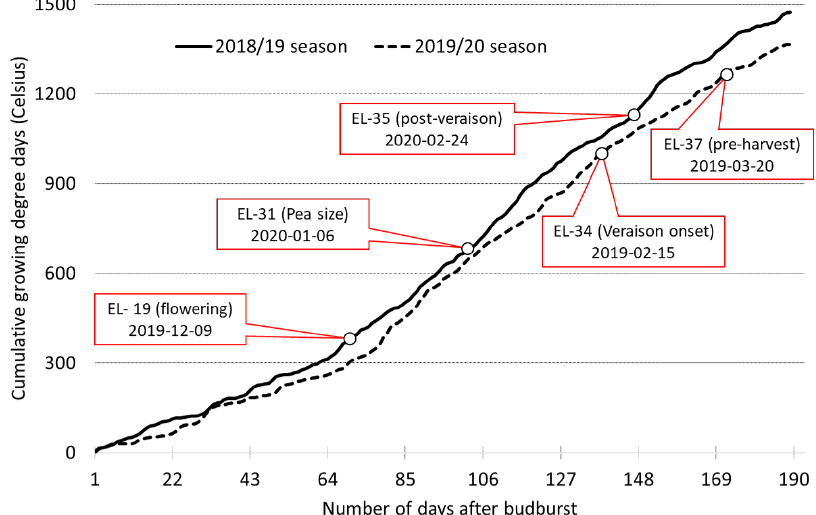
Figure 5. The cumulative growing degree days for the Cabernet Sauvignon at the Wynns Coonawarra Estate, Coonawarra for the two seasons, 2018/19 and 2019/20. The data acquisition stages for both seasons are